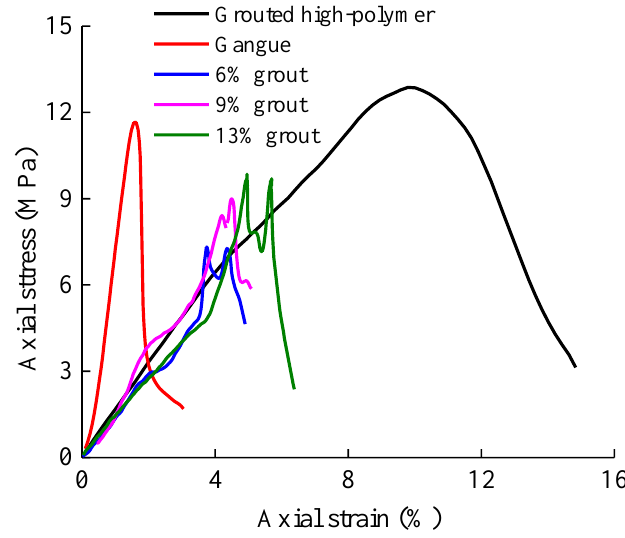
Figure 9. Stress–strain curve of the grouted gangue specimens.